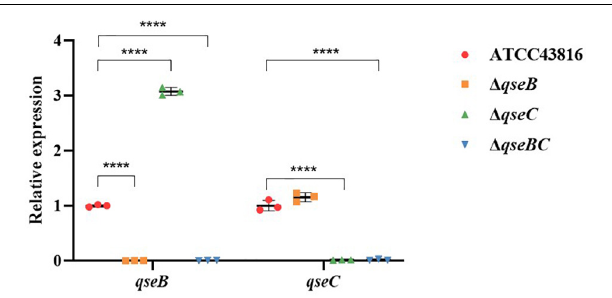
FIGURE 6 | Expression of genes qseB , qseC in ATCC43816, (cid:49) qseB , (cid:49) qseC and (cid:49) qseBC . Cultures of the wild-type and mutants were grown in LB medium to late-exponential phase, and expressions of genes qseC , qseB were measured by qRT-PCR and normalized to the expression in the wild-type strain. Data were mean ± standard deviation of three replicates. Significant expression differences between the wild-type andmutants were determined using two-way ANOVA, **** P < 0.0001.